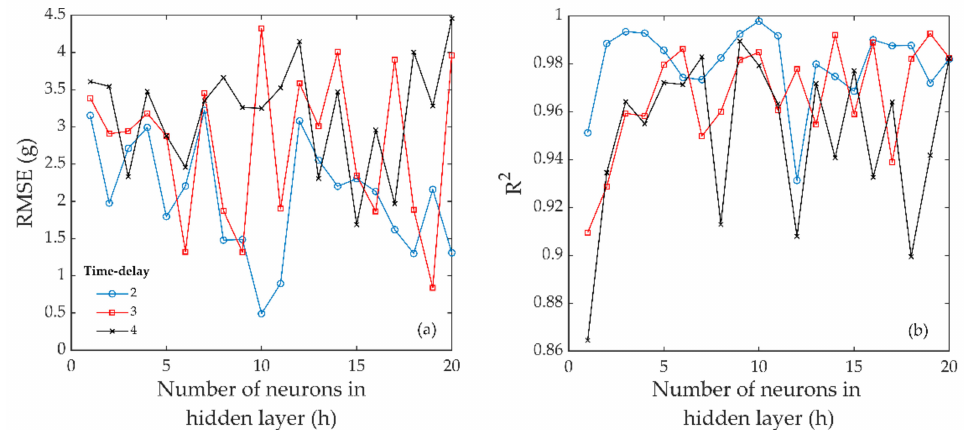
Figure 6. The relationship between the time-delay order ( dt ), the number of neurons in the hidden layer (h), and model performances: ( a ) root-mean-squared error (RMSE) and ( b ) R 2 .